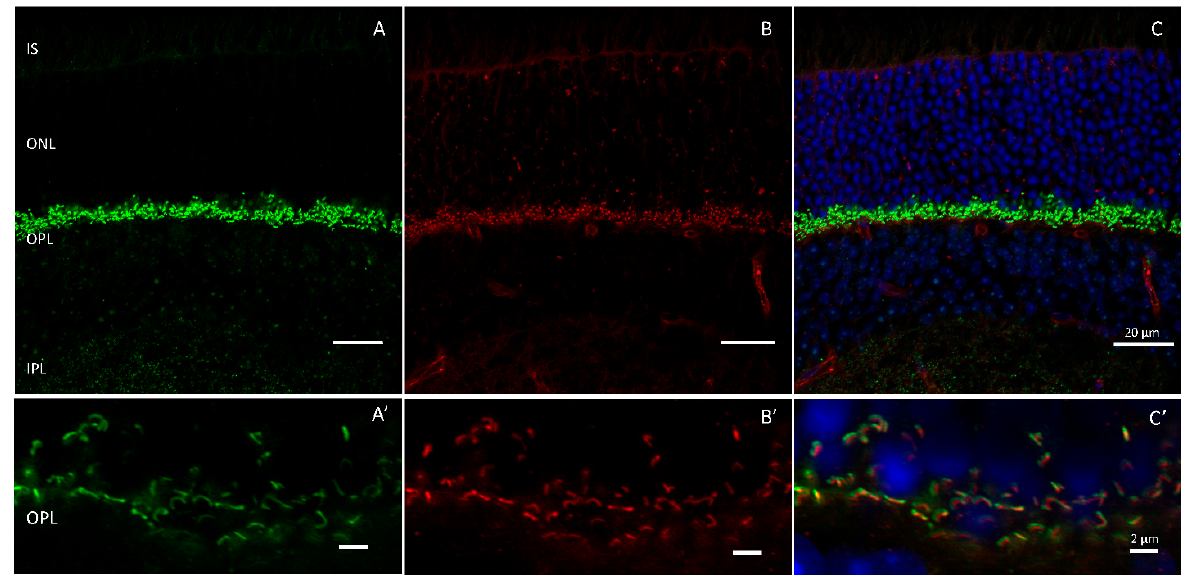
Figure 4. Calcium channels are localized to the outer plexiform layer where they are closely associated with ribbons at the synapse. Shown is antibody staining of an adult wildtype mouse retina labeled with ( A ) Ribeye (green) and ( B ) Calcium channel pore forming subunit, α 1F (red). ( C ) merged. Outer plexiform layer shown in ( A’ – C’ ). Scale bar = 20 µm in ( A – C ) and 2 µm in ( A’ – C’ ).